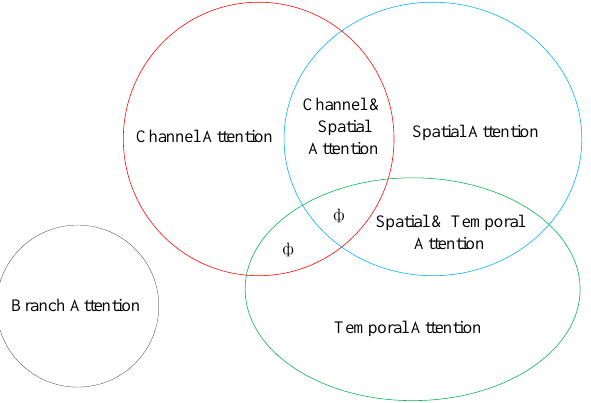
Figure 2. Classification of attentional mechanisms ( ф indicates no relevant classification).